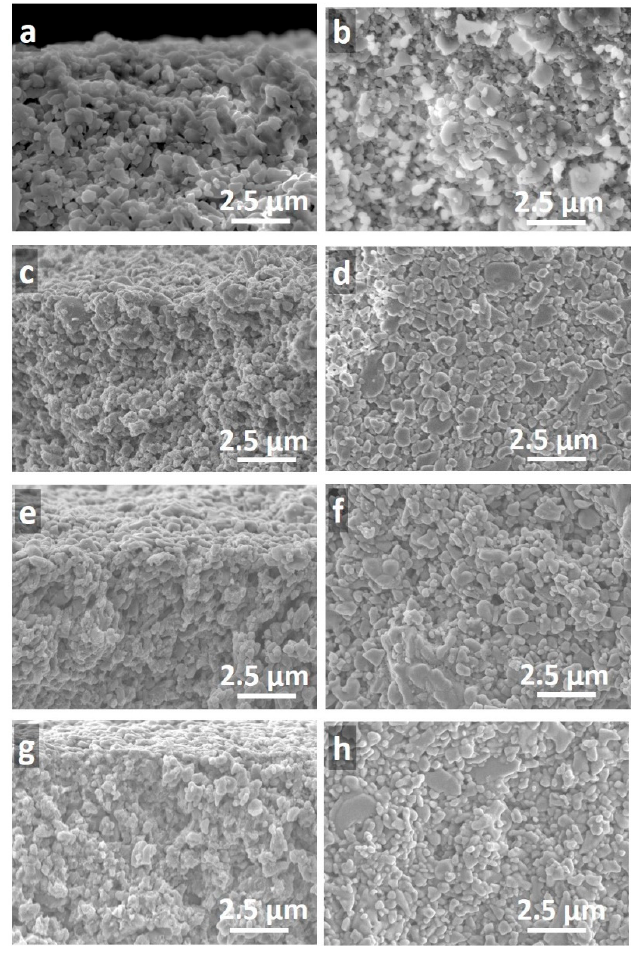
Figure 3. Scanning electron microscopy (SEM) of the cross-section of ( a ) alumina substrate and the TM1200 membranes for ( c ) one layer ( e ) two layers ( g ) three layers and their corresponding surface morphology of ( b ) alumina substrate ( d ) one layer ( f ) two layers and ( h ) three layers of TM1200 membranes.